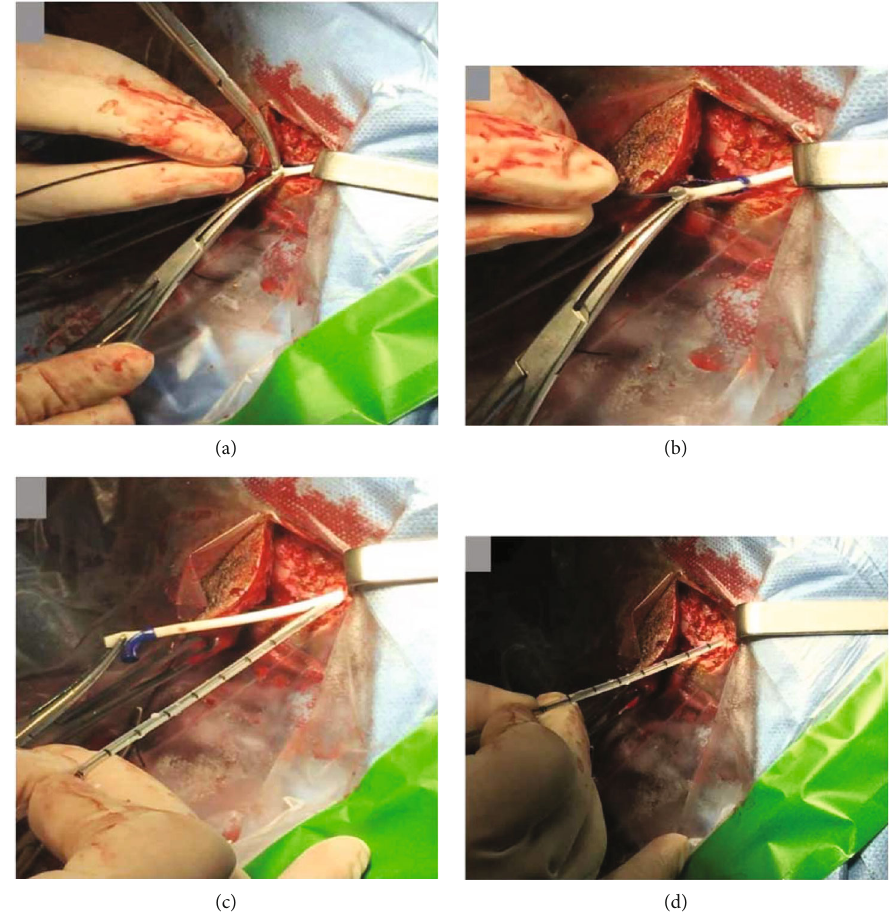
Figure 3: Ventricular catheter removal technique. (a) The monopolar wire being introduced inside the ventricular catheter. Two Kelly forceps were used to fi x the catheter. (b) Introduction of the monopolar wire into the existing proximal catheter. (c) Previous catheter removal. The new catheter was positioned very close to the burr hole. (d) The ventricular catheter was inserted using the previous